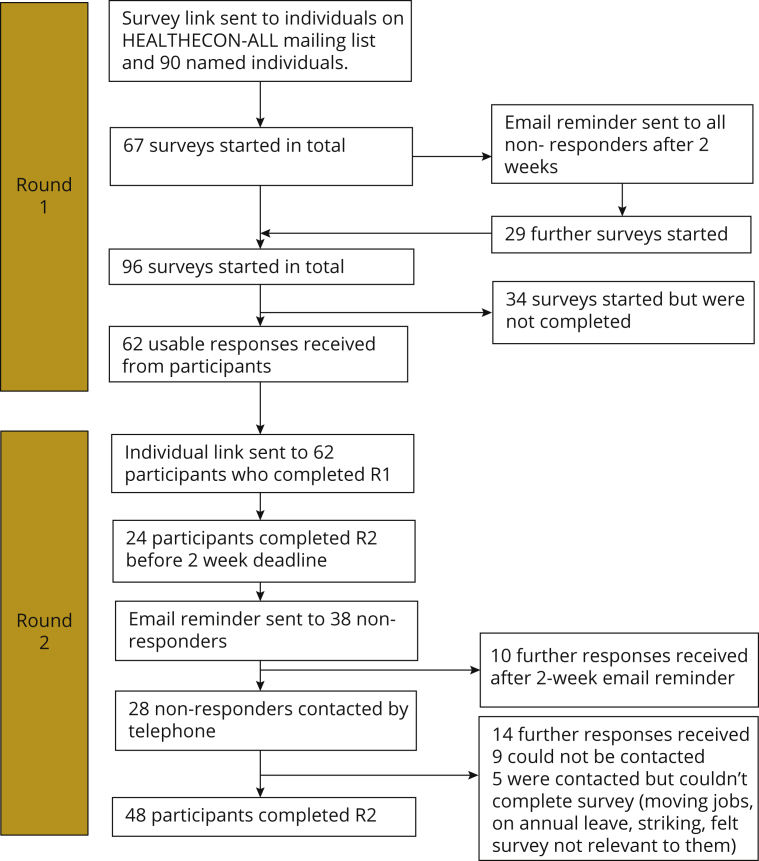
Delphi survey participant numbers. (R1 = round 1, R2 = round 2).